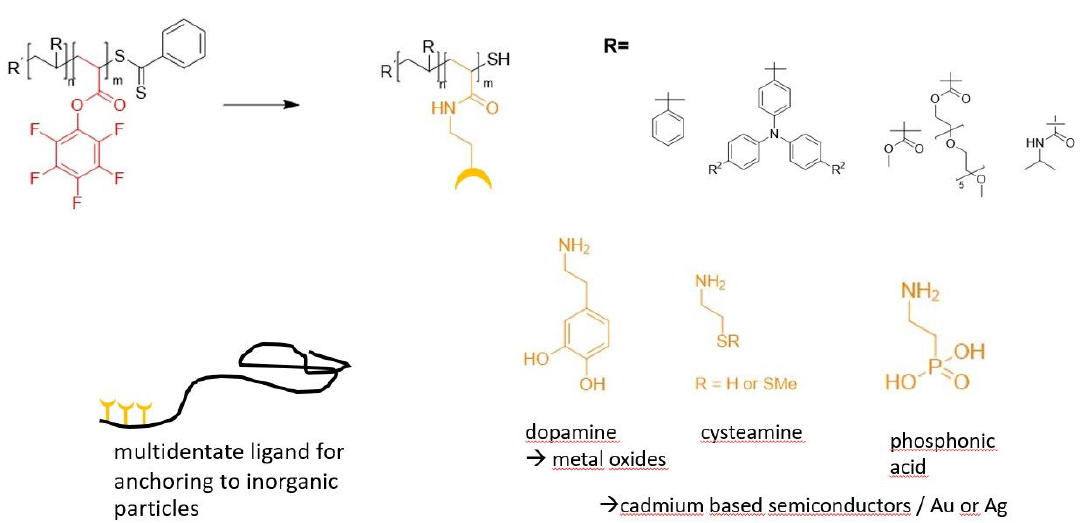
Figure 3. Recently established synthetic route [20,21] to blockcopolymers with multidentate block for the ligand exchange on nanoparticles.